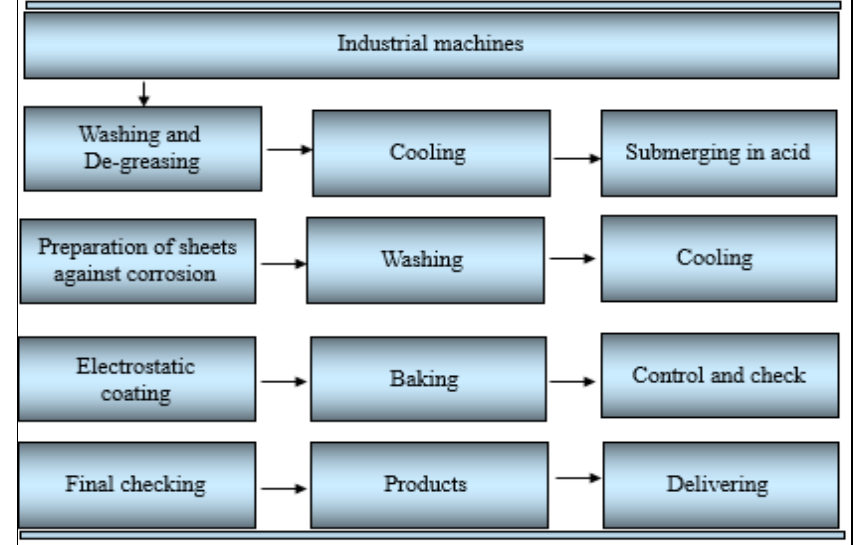
Figure 2: The layout of units of the electrostatic coating